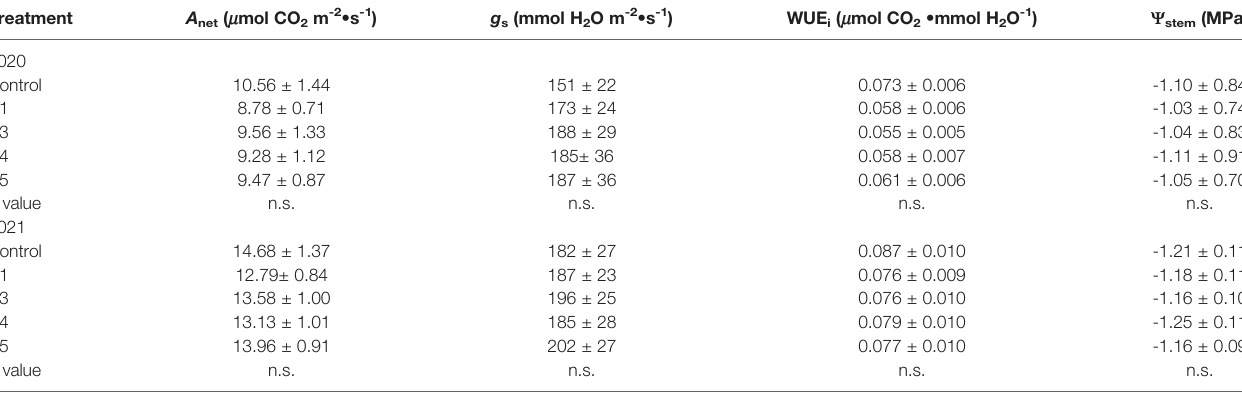
TABLE 2 | Effects of photo-selective overhead shade fi lms on integrals of leaf gas exchange and mid-day stem water potential integrals on Cabernet Sauvignon/110R in Oakville, CA USA ab .